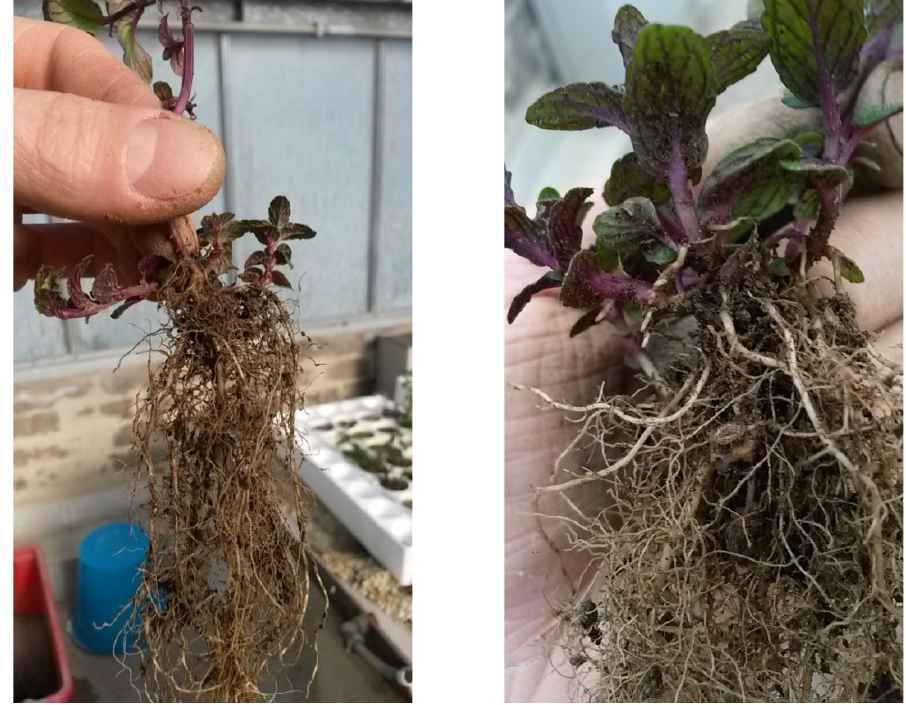
Figure 4. Conversion ( left ) and development of abundant roots and new stolons ( right ) from synthetic seeds of Mentha spicata .